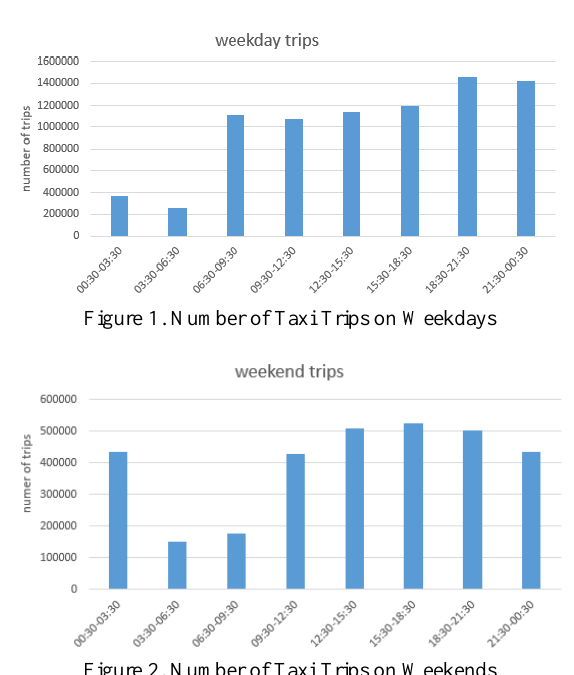
Figure 2. Number of Taxi Trips on Weekends